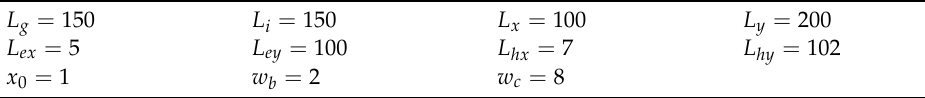
Table 1. Geometric parameters (in µ m), as shown in Figure 5.